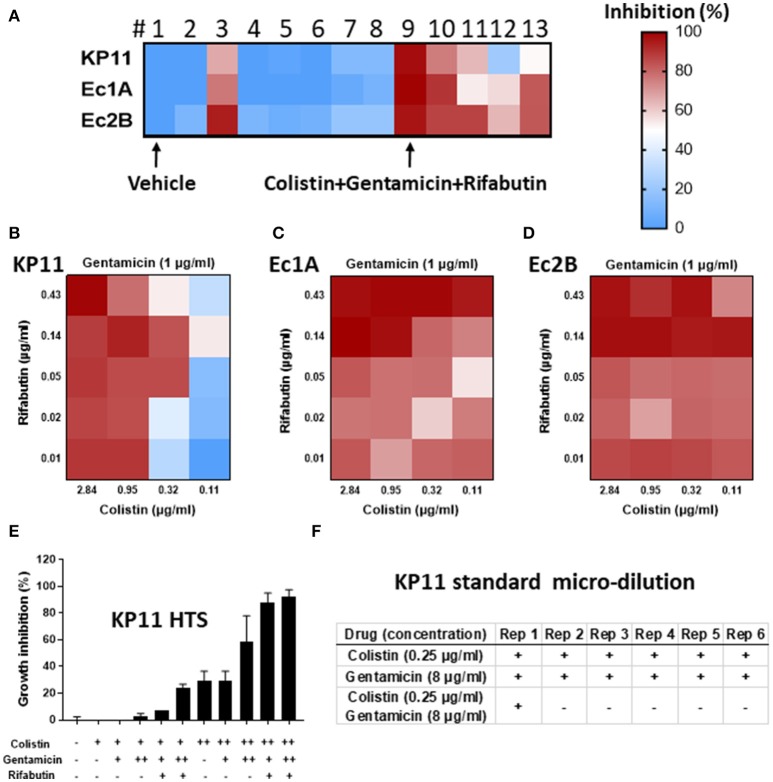
“Real-time” high-throughput drug and combination testing against multidrug-resistant organisms (MDRO). A total of 8 drugs and 14 drug combinations (in 2,304 samples) were tested against three MDRO K. pneumoniae-KP11, E. coli-Ec1A and E. coli-Ec2B. (A–D) Growth inhibition of KP11, Ec1A and Ec2B by individual drugs (1 vehicle; 2 gentamicin; 3 colistin; 4 rifabutin; 5 imipenem; 6 ceftazidime; 7 meropenem; 8 tigecycline) and drug combinations (9 colistin+gentamicin+rifabutin, 10 colistin+imipenem+rifabutin, 11 meropenem+tigecycline+colistin, 12 meropenem+tigecycline+colistin+ceftazidime, 13 meropenem+tigecycline+colistin+rifabutin) in high-throughput bacterial assay. Colors represent drug potency (% of growth inhibition). Vehicle control was normalized as 0% inhibition and no bacterium was normalized as 100% inhibition. n = 4, mean ± SEM. (E) Growth inhibition of KP11 by combinations of colistin, gentamicin, and rifabutin in high-throughput bacterial assay. Vehicle (–), colistin at 0.5 μg/ml (+) or 2 μg/ml (++), gentamicin at 1 μg/ml (+) or 4 μg/ml (++), or rifabutin at 0.06 μg/ml were tested at indicated conditions. n = 3, mean ± SEM. (F) Growth inhibition of KP11 by colistin, gentamicin, and the combination of colistin and gentamicin in standard micro-broth assay. 100 μg/ml meropenem (–) or vehicle alone (+) were included as control. + was visual bacterial growth. – was no visual bacterial growth. Rep, repeat. n = 6.